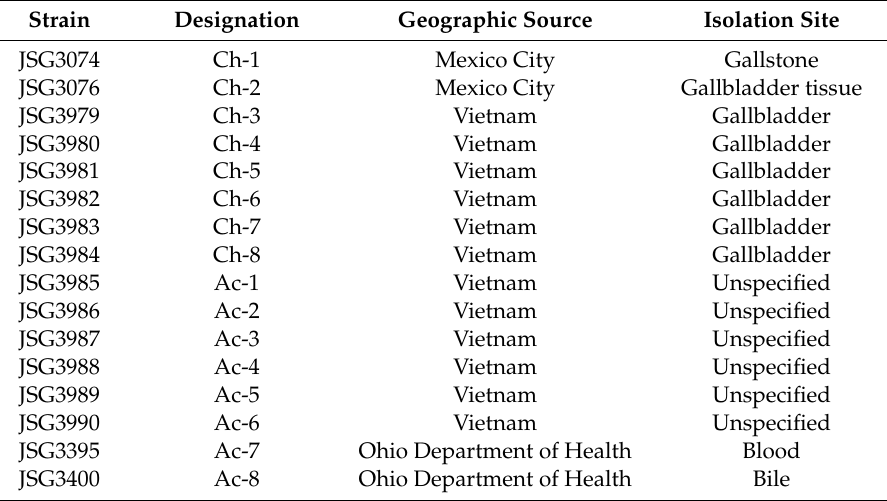
Table 2. Clinical isolates used in this